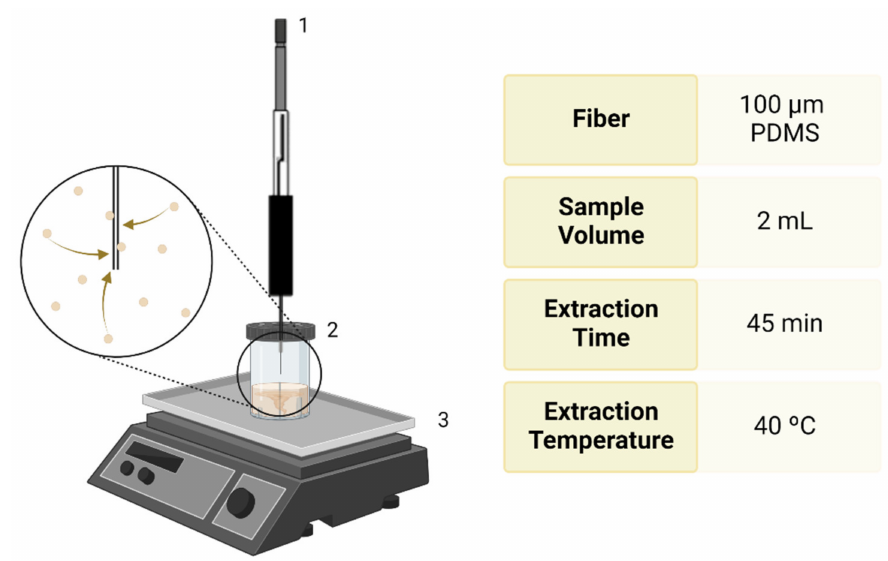
Figure 1. Schematic representation of VOC extraction from FF: (1) SPME syringe; (2) vial with 2 mL of FF; (3) heating mantle with magnetic stirrer. Created using